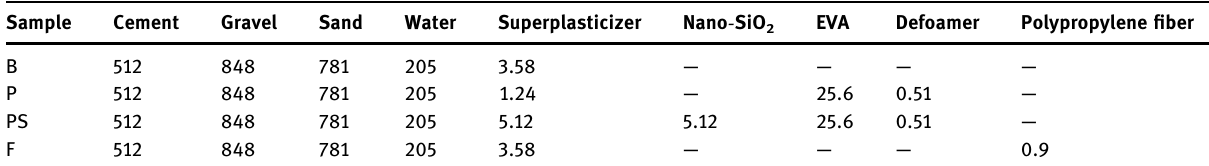
Table 5: Mix proportion of self - compacting fi ne stone concrete ( kg/m 3 )